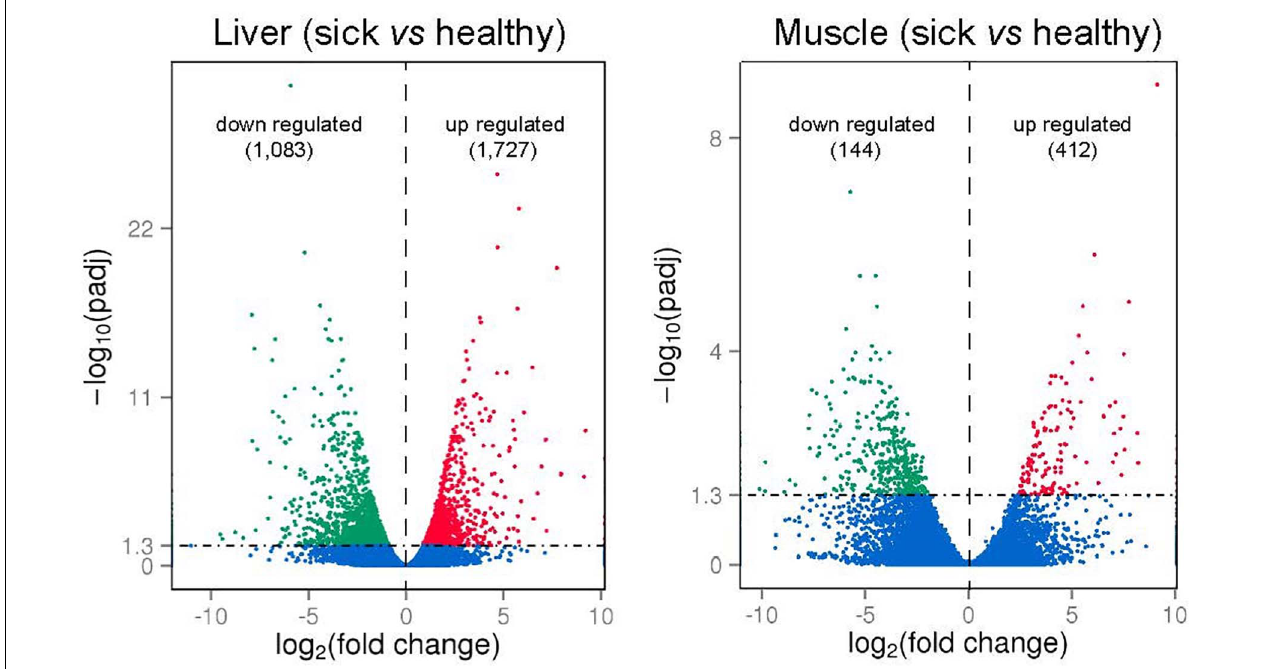
FIGURE 5 | Volcano plots of differently expressed genes (DEGs; numbers up- or downregulated in brackets) in liver and muscle of sick vs. healthy barramundi. x -axis represents log 2 -transformed fold change and the y -axis indicates –log 10 -transformed adjusted significance. Each dot indicates an individual gene that was significantly upregulated (red), downregulated (green), and non-differentially regulated (blue). The horizontal line represents adjusted P -value ( P < 0.05